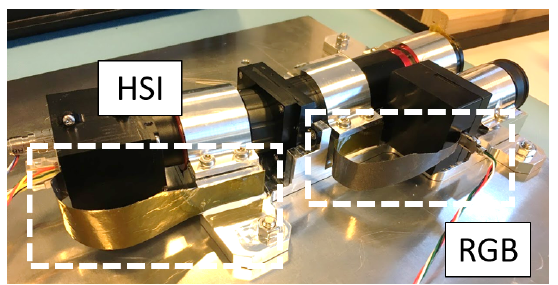
Figure 10. Thermal straps assist with heat dissipation from active electronics boards in the HSI and RGB (heat source) to the payload platform (heat sink). Additionally, black features in the image are